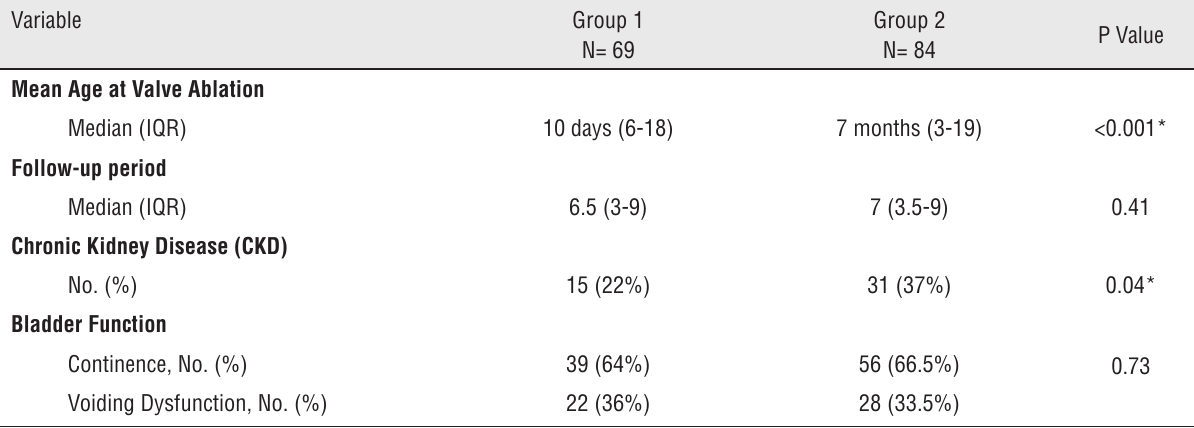
Table 1 - Comparison of the patients’ outcome in both